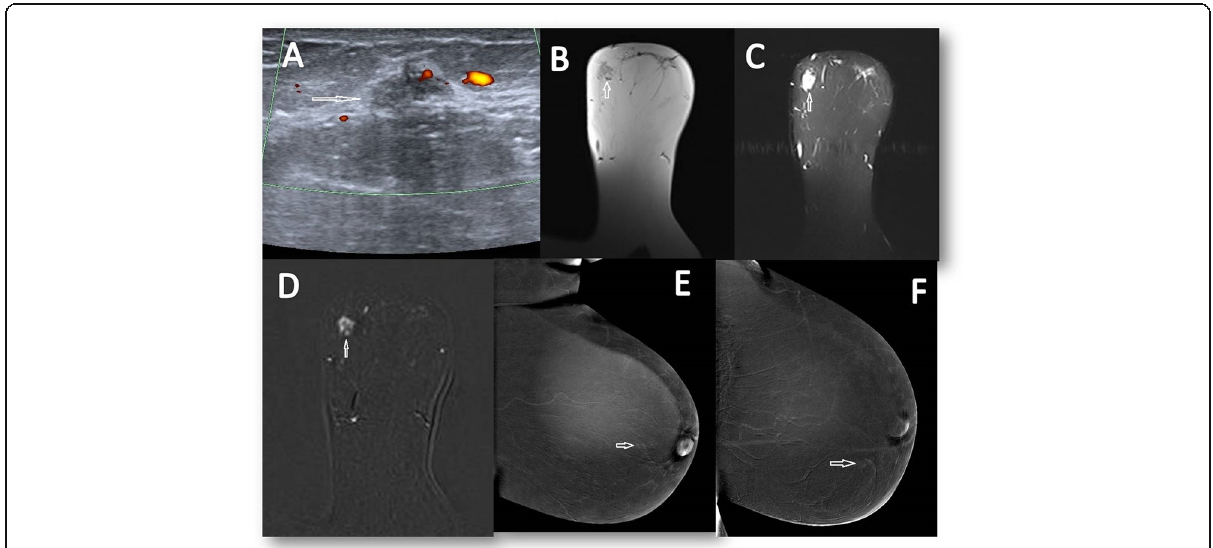
Fig. 4 Female patient 71 years old. She was presented with left breast mass. On mammography ( a ), slight irregular lesion is seen at 12 o ’ clock (arrow). On ultrasound ( b ), the lesion appears as a fairly defined hypoechoic lesion with a tongue-like projections (arrows). On CESM ( c , d ), it appears irregular with moderate enhancement (long arrow) and with enhancing axillary LNS (asterisk) on MLO view. A small enhancing nodule is seen deep to the lesion on CC view (small arrow on c ), but it was not seen on MLO view. On MRI, the lesion is irregular, enhancing (long arrow) with enhancement curve type III and with a ductal linear enhancement extending posteriorly to small enhancing satellite lesion (small arrow). An enlarged pathological rounded axillary LNS (asterisk). A biopsy was done and histopathologically proven as invasive ductal carcinoma with DCIS